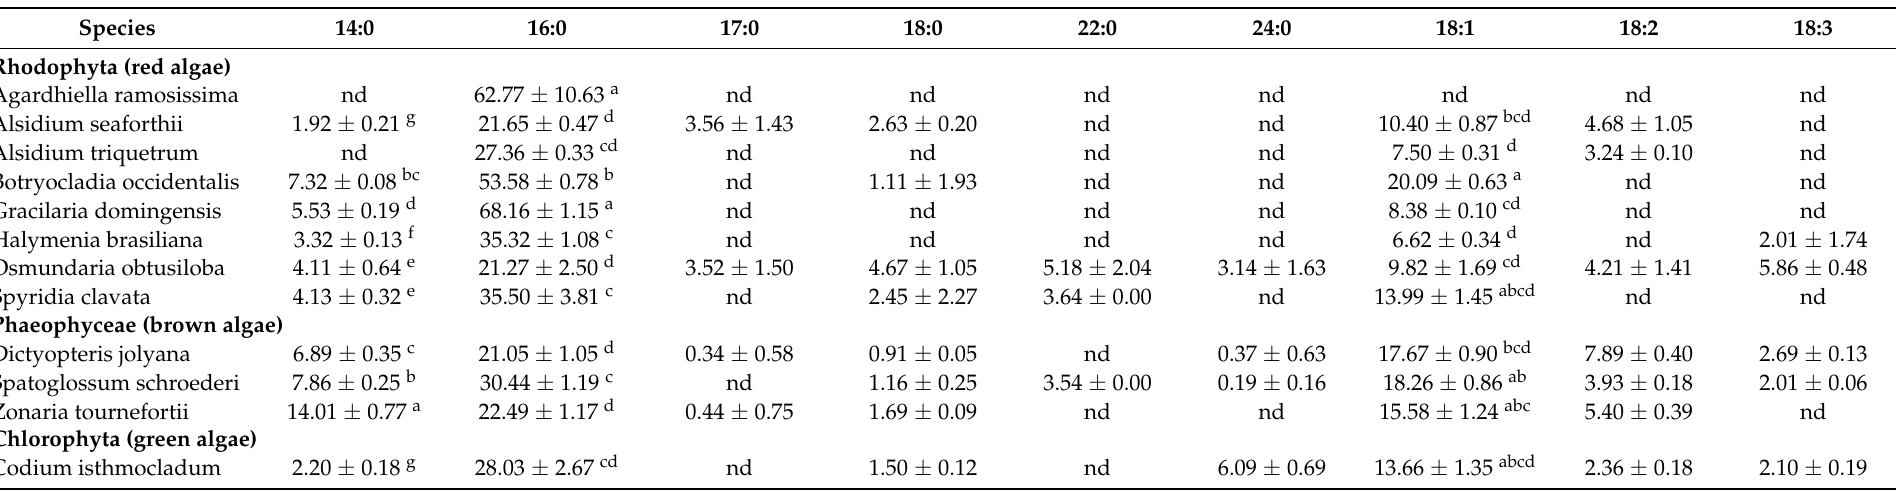
Table 4. Fatty acid composition of beach-cast macroalgae (g/100 g on dry mass basis). Values represent the average of three replicates (mean ± SD), and letters indicate statistical significance ( p < 0.05). Statistical analysis was performed only for amounts over 10. nd = not